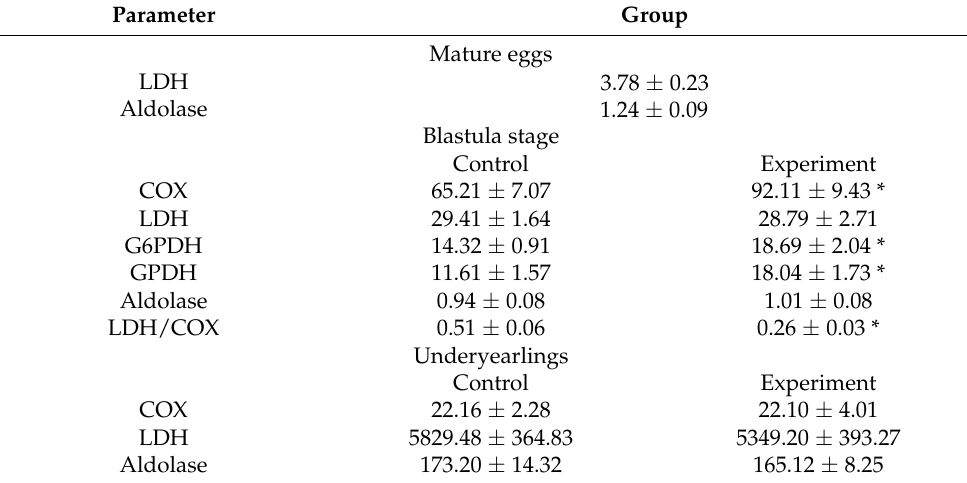
Table 3. The activity of energetic and carbohydrate enzymes (nmol × min − 1 × mg − 1 protein) in mature eggs, at the blastula stage and in underyearlings of Atlantic salmon in control and He-Ne lase